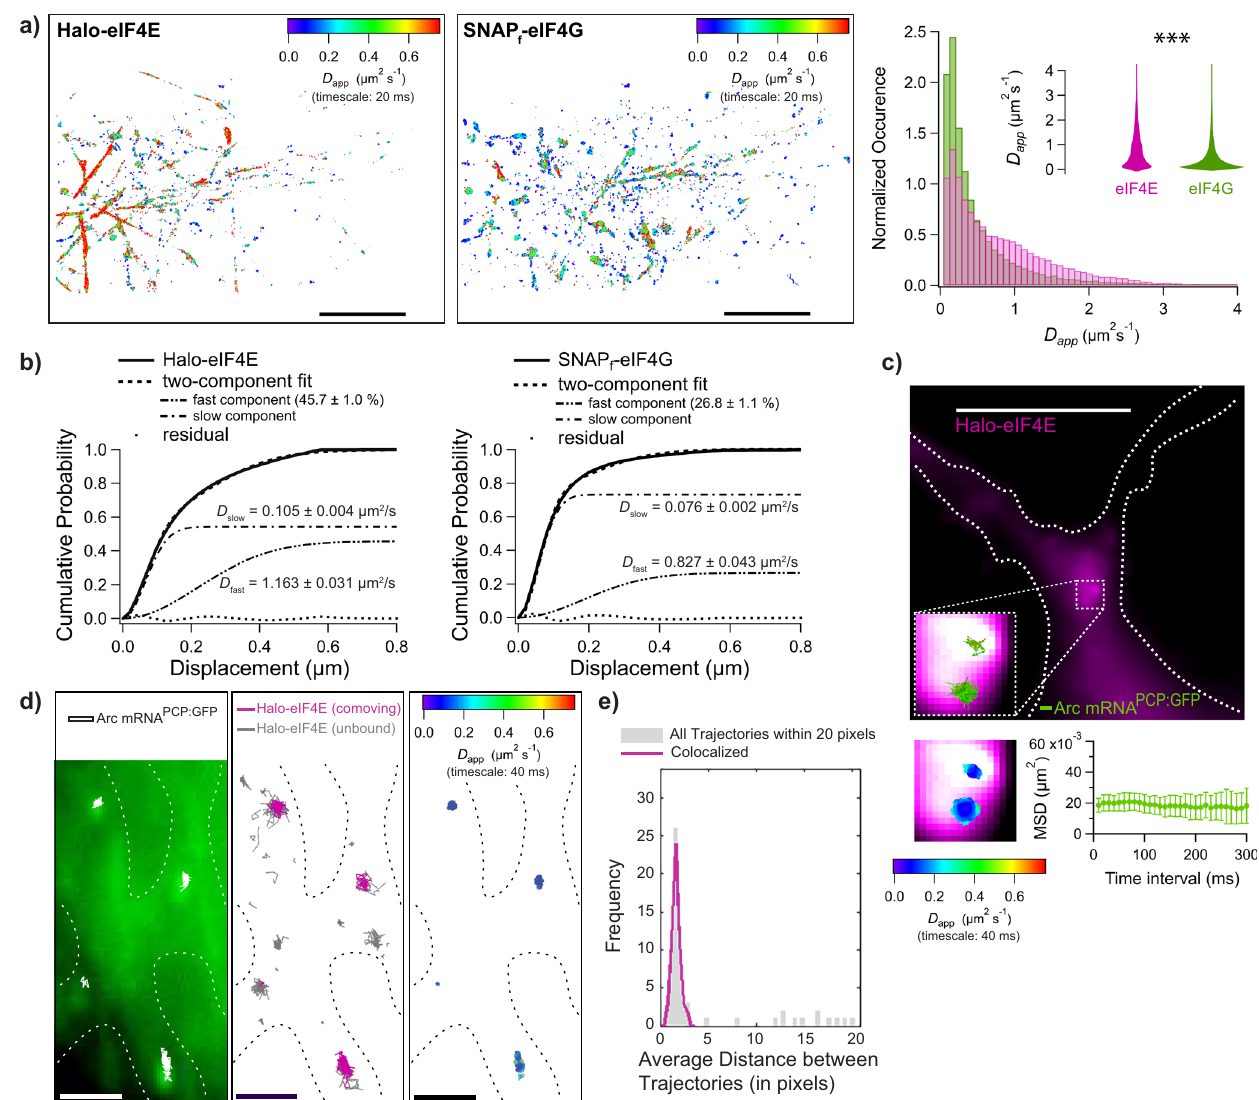
Fig. 6 | Simultaneous single-particle tracking of endogenous Halo-eIF4E and SNAP f -eIF4G in mESC cells that were differentiated into neurons. a Top left: Diffusion heatmapof 18,220 JF585 Halo-eIF4Etrajectories from eight 10,000 frames 50Hz movies obtained from a dense network consisting of more than 100 indivi- dual dendritic branches (scale bar: 10 μ m). Top center: The corresponding heat map of the simultaneously recorded 26,438 JF646 SNAP f -eIF4G trajectories. Top right: The distributions of apparent diffusion coef fi cients of JF585 Halo-eIF4E (in green)and JF646 SNAP f -eIF4G(inmagenta).Two-sided t -testwithtwomeanvaluesof two distributions(***means p < 0.001). b Cumulative distributionfunctions(CDF) were obtained from26,438 eIF4Gand 18,220eIF4Etrajectories. While the majority of Halo-eIF4E exhibit slow diffusion (54.3±1.0%), this percentage increases to 73.2±1.1% for SNAP f -eIF4G. c Thick dendritic process of a cortical neuron from ARC P/+ ;PCP-GFP;v-Glut2Cre mice expressing Halo-eIF4E after TTX withdrawal (dotted outline, scale bar: 10 μ m). The median projection of the JF646 Halo-eIF4E channel of 5000 frames was recorded at 100Hz (in magenta). Overlay of two ARC